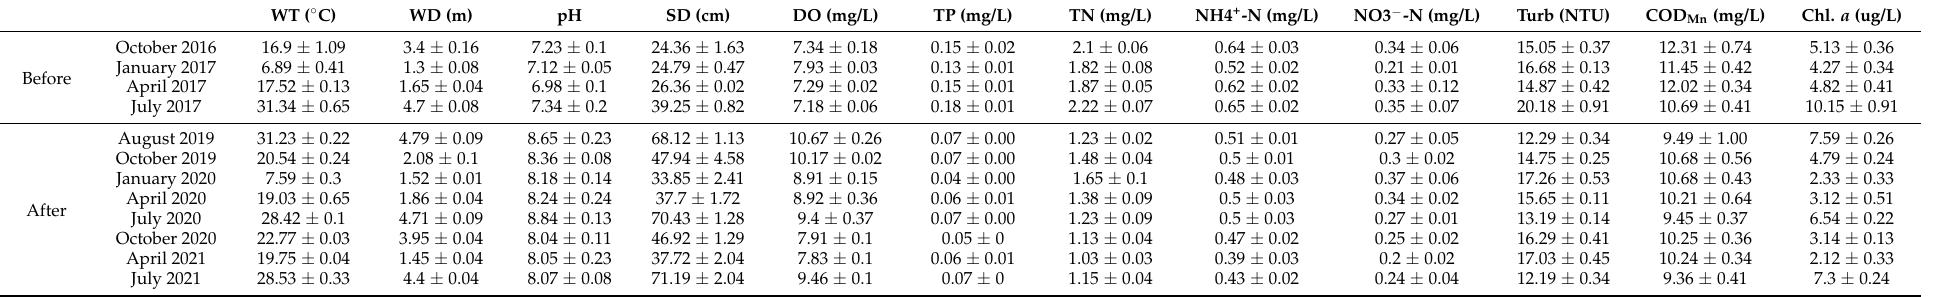
Table 1. Physical and chemical factors of water before and after aquatic vegetation restoration (average value ± standard deviation). Before stands for before recovery and After stands for after recovery. January is winter, April is spring, July and August are summer, and October is